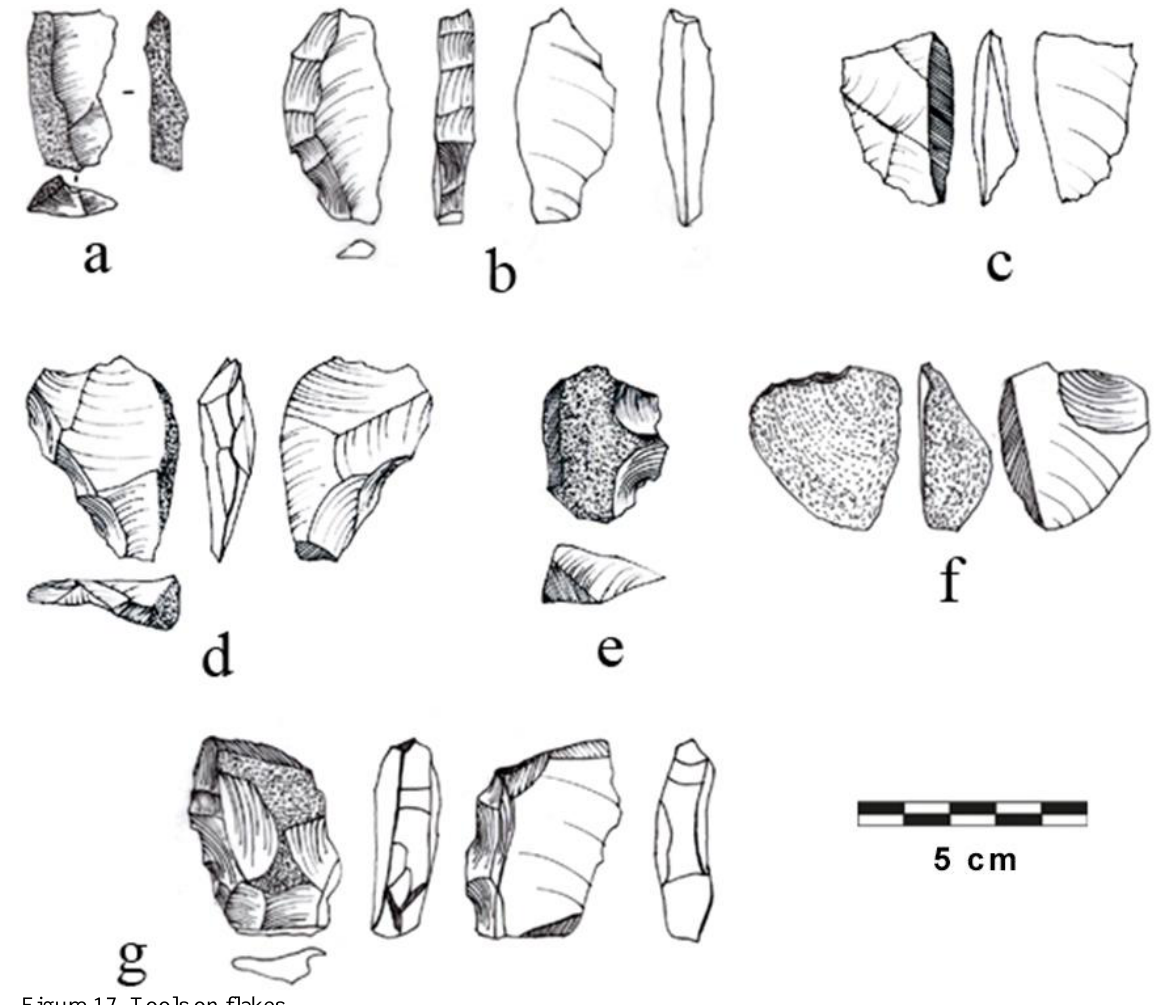
Figure 17. Tools on